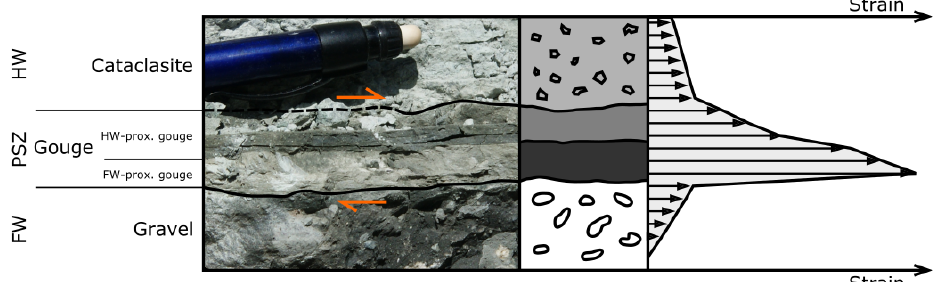
Figure 10. Conceptual model providing a potential explanation of how layered principal slip zones observed at Martyr River and Waikukupa Thrust could have been formed. Resulting from the juxtaposition of weakly consolidated sediments in the footwall and relatively competent fault rocks, strain localized non-homogenously in the PSZ. The photograph example is from Waikukupa Thrust. The stippled line indicates where the contact between cataclasite and gouge is obscured by debris. The figure was modified from Cowan et al.